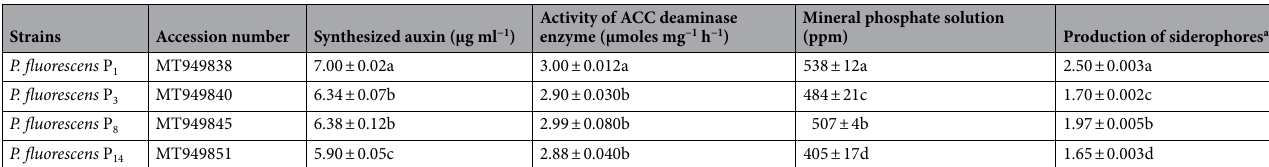
Table 1. Characterization of the Pseudomonas fluorescens strains. a Halo diameter to colony diameter after 5 days incubation. Values are means of 3 replicates ± standard error compared by LSD at p ≤ 0.05. Values followed by the same letter (a–d) within the same column are not significantly different at P =